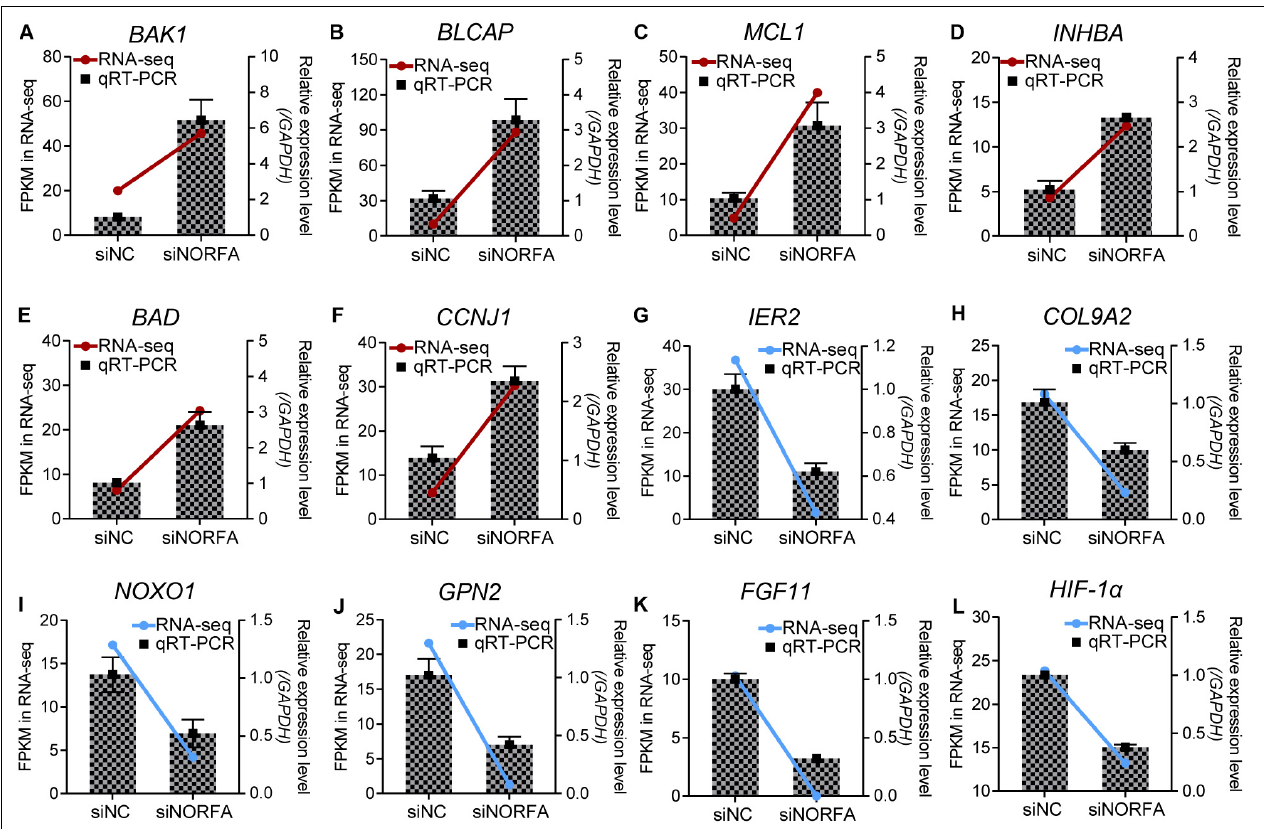
FIGURE 3 | Multiple crucial genes were influenced by NORFA in porcine GCs. A total of 12 key DEmRNAs that are essential for cell states and functions were selected, and their expression patterns in porcine GCs treated with siNORFA were validated by qRT-PCR ( n = 3). (A–F) Six up-regulated DEmRNAs and (G–L) six down-regulated DEmRNAs. The color lines showing the expression patterns of DEmRNAs in RNA-seq, which refers to the left y- axis (red and blue indicate up- and down-regulated). The columns represent qRT-PCR results by referring to the right y -axis (mean ± S.E.M.; n =